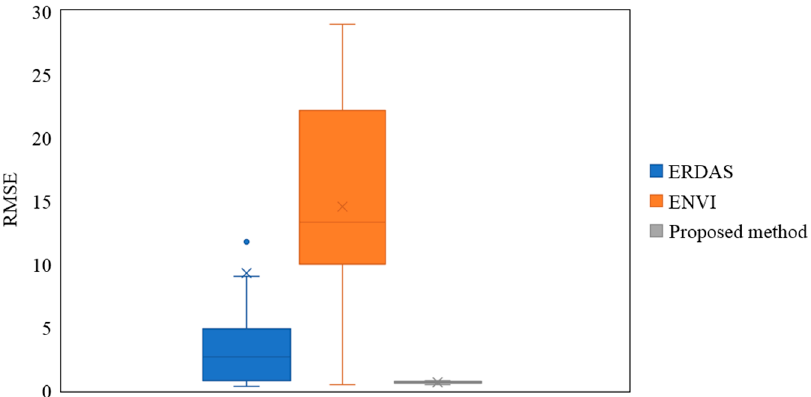
Figure 17. Box plots for comparison of the RMSE from ERDAS, ENVI, and the proposed method.